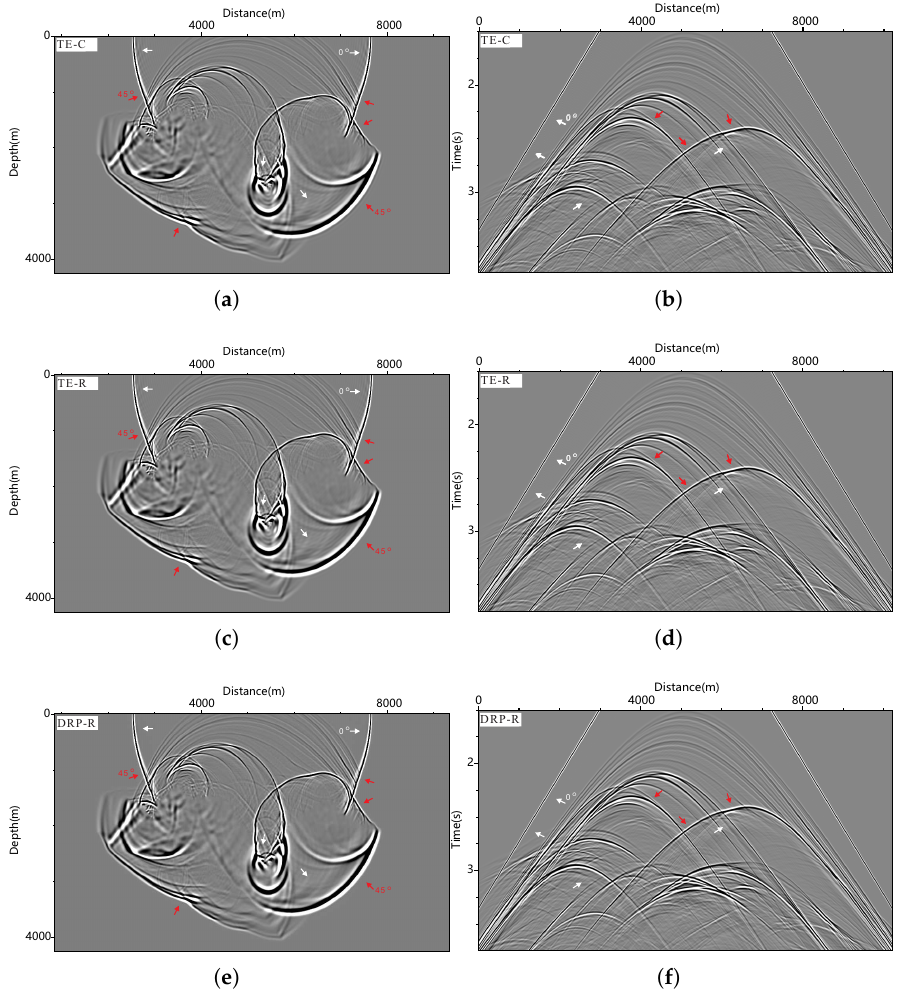
Figure 7. Snapshots and corresponding seismic records of the 2D Sigsbee velocity model. Here, M = 8, N = M , ∆ t = 0.0009 (s) and h = 8.5 (m). ( a , b ) The TE-C method. ( c , d ) The TE-R method. ( e , f ) The DRP-R